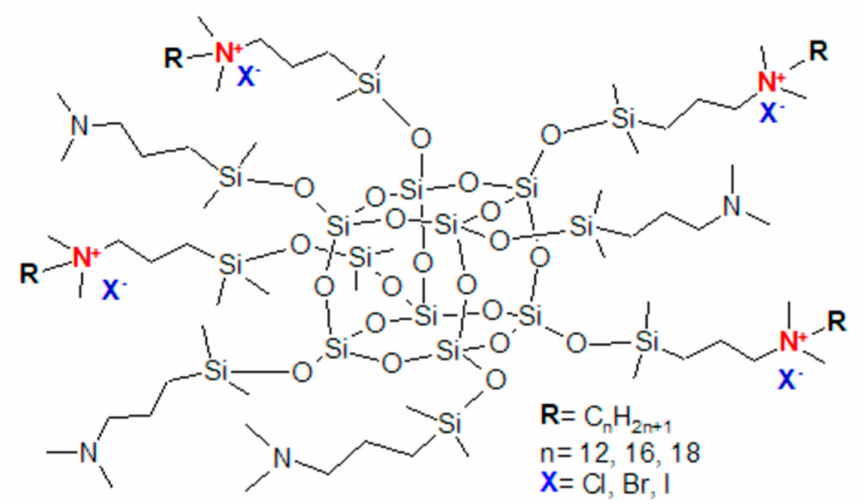
Figure 2. Q-POSS idealized structure. Reprinted with permission from P. Majumdar, E. Lee,